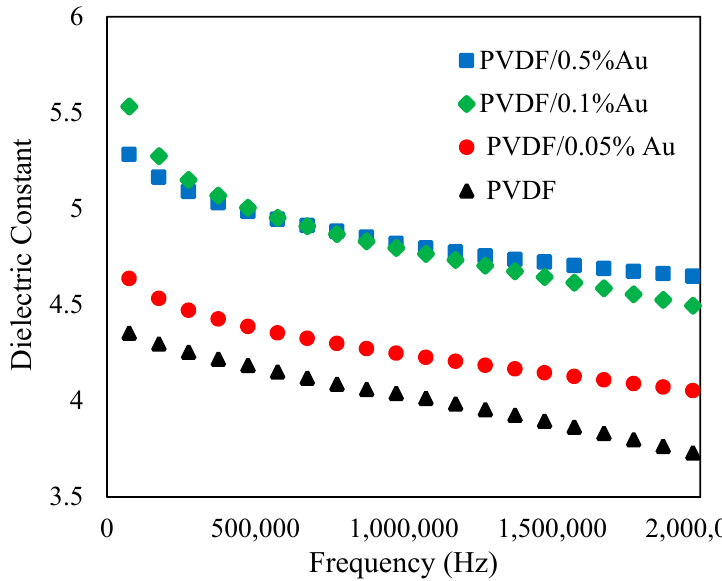
Figure 9. Dielectric constant PVDF and PVDF/Au nanocomposites.